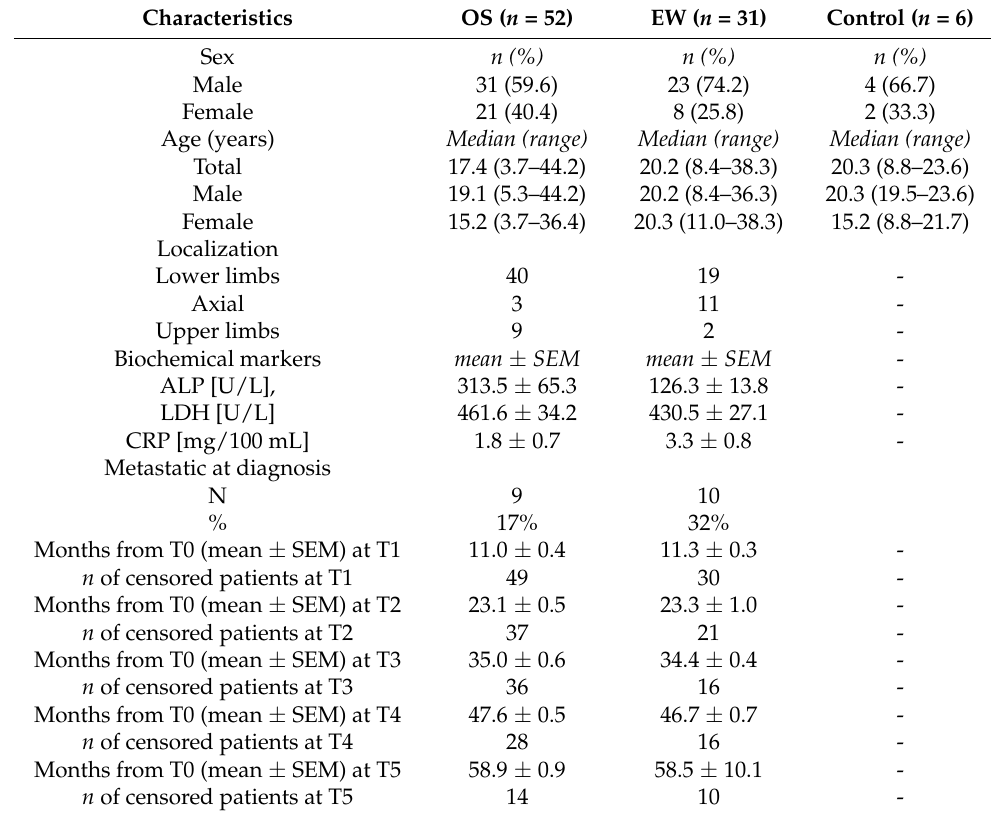
Table 1. Characteristics of study participants. Alkaline phosphatase (ALP), lactate dehydrogenase (LDH), C-reactive protein